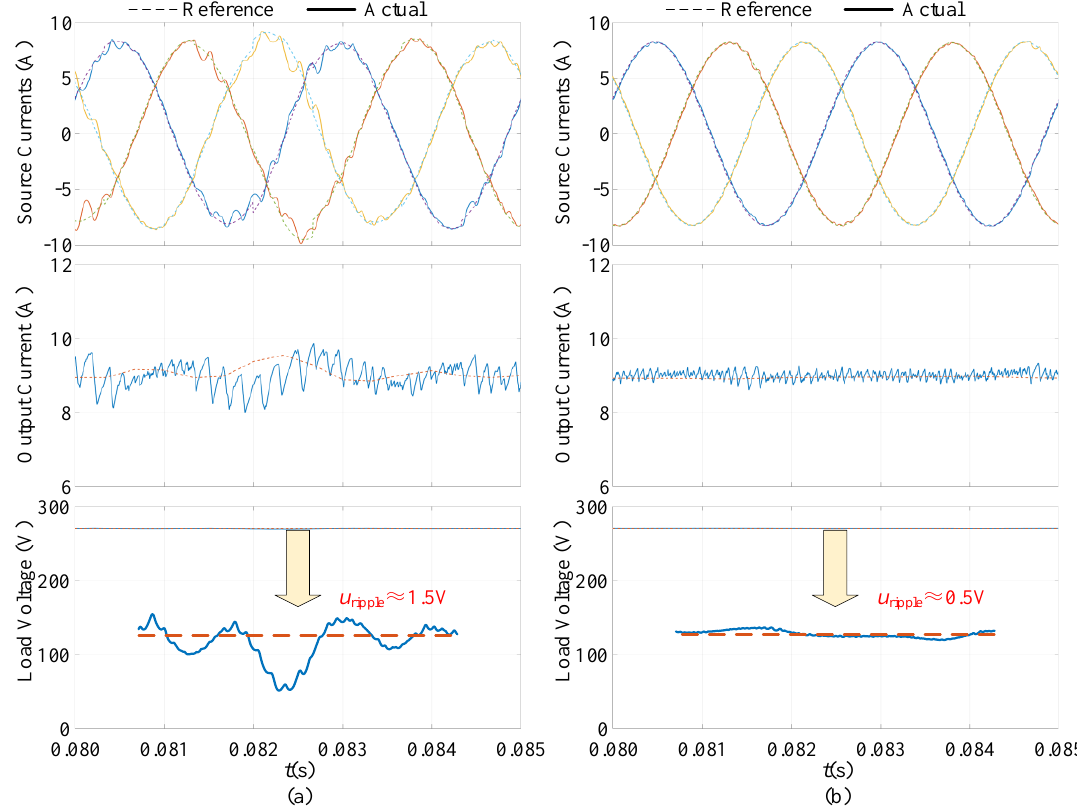
Figure 5. Simulation results of CSC with the proposed control scheme at the nominal conditions: ( a ) the output sampling time T so was 333 s and ( b ) T so was 667 s. 263